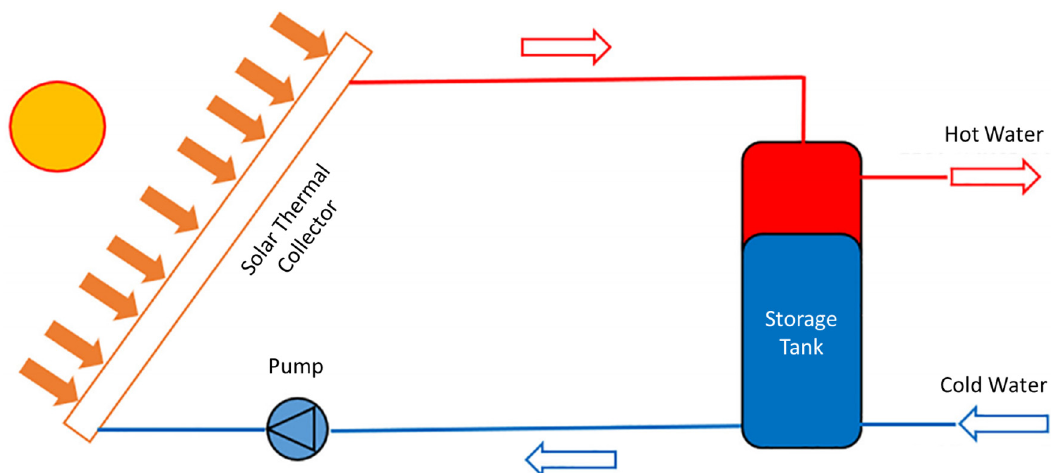
Fig. 1. Flowsheet of a solar thermal energy system including a solar collector and a water storage tank (schematics adapted